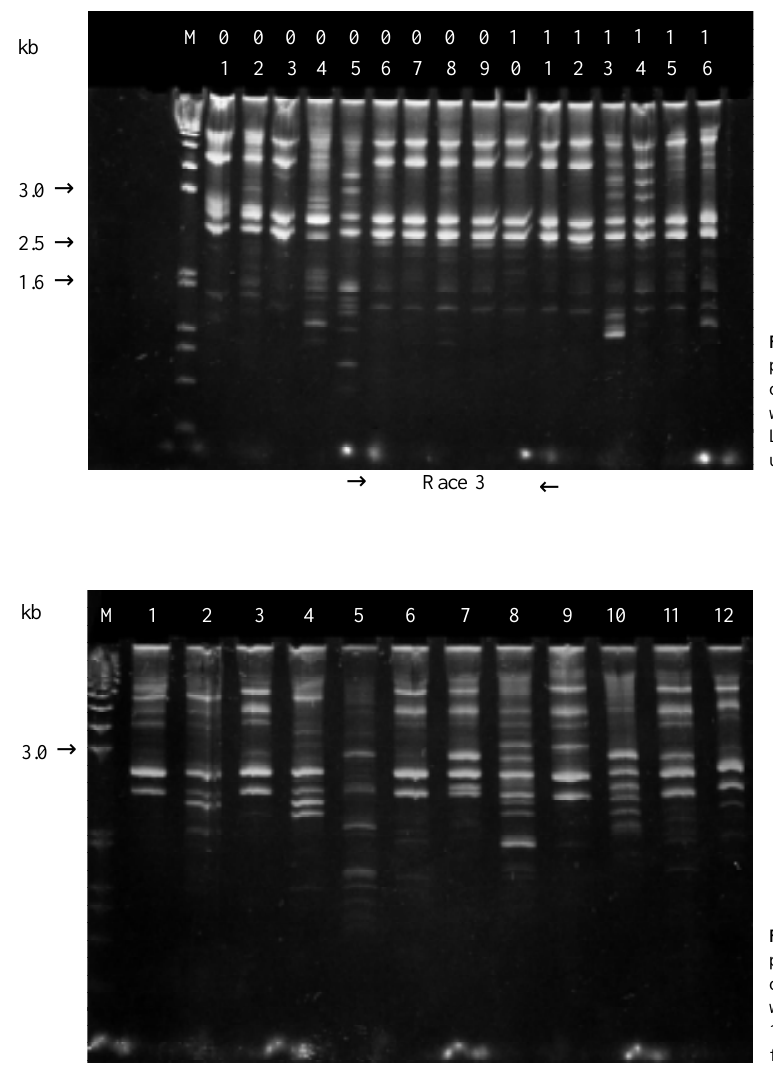
Figure 3 - Electrophoretic analysis of DNA amplification products from Heterodera glycines populations obtained on 8% polyacrylamide gel. Amplifications were performed with primer OPA-10. Lane M = Molecular size standard. Lanes 1 through 12 correspond to the amplification products of the first 12 SCN populations, as identified in Table I.